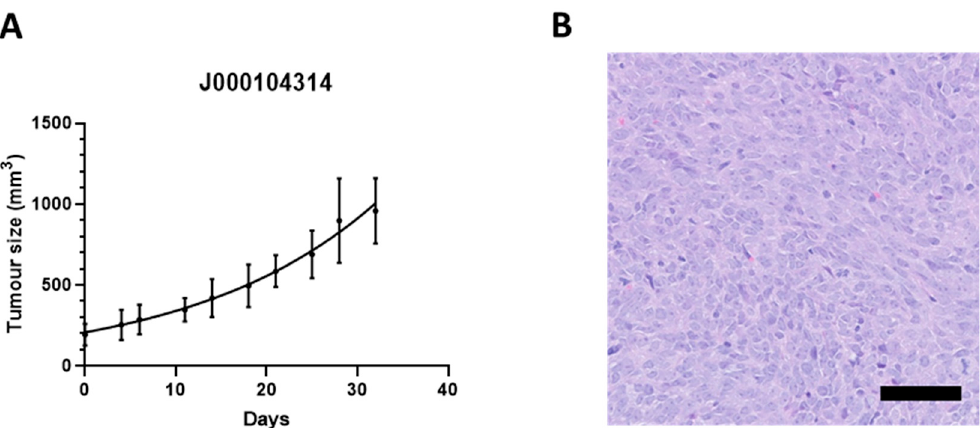
Figure 1. ( A ) Tumour growth curve of the J000104314 patient-derived xenograft model. n = 5. ( B ) H&E stain of tumour section from the J000104314 patient-derived xenograft model. Scale bar = 50 µm.